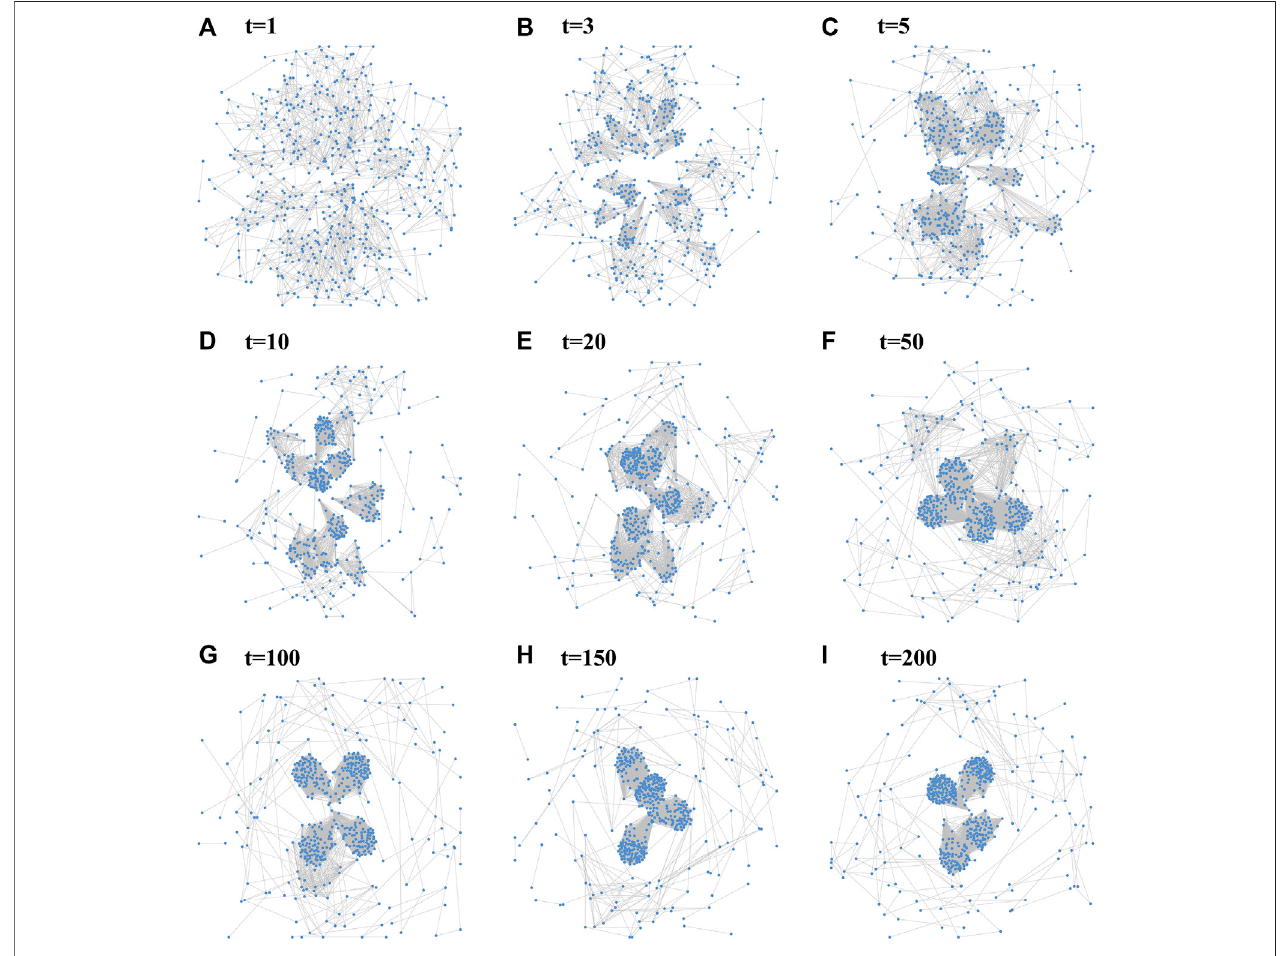
FIGURE6| Demonstrationofnetworkevolutionprocessinthehighdimensionalvectorspacewithparameters γ (cid:1) 0.2, ϵ (cid:1) 0.2,networksize (cid:1) 500, (A) t (cid:1) 1, (B) t (cid:1) 3, (C) t (cid:1) 5, (D) t (cid:1) 10, (E) t (cid:1) 20, (F) t (cid:1) 50, (G) t (cid:1) 100, (H) t (cid:1) 150, (I) t (cid:1)